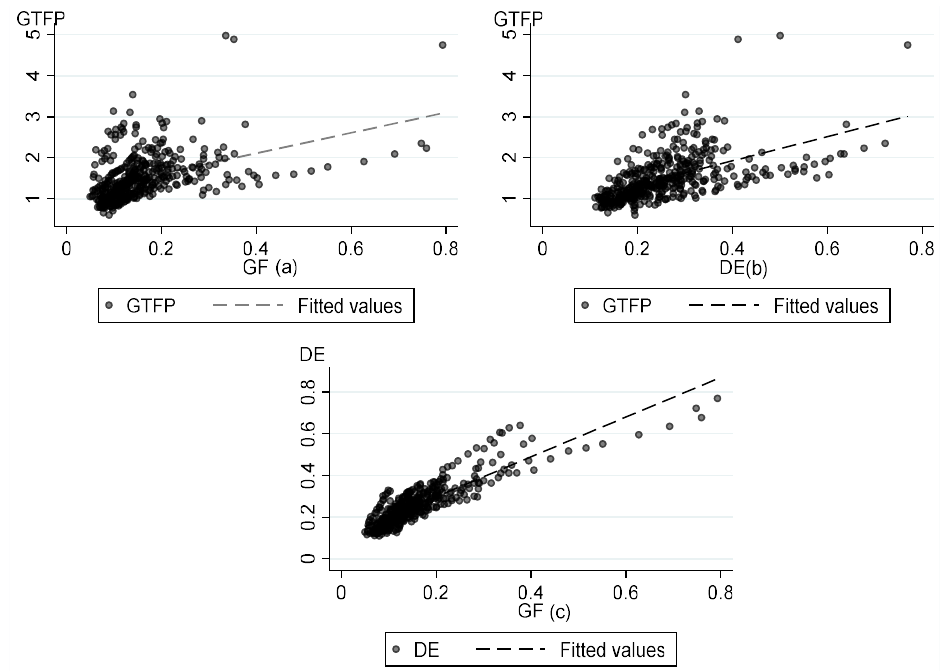
Figure 2. The relationship between GF , DE and GTFP . ( a ) shows the relationship between GF and GTFP ; ( b ) shows the relationship between DE and GTFP ; ( c ) shows the relationship between GF and DE .